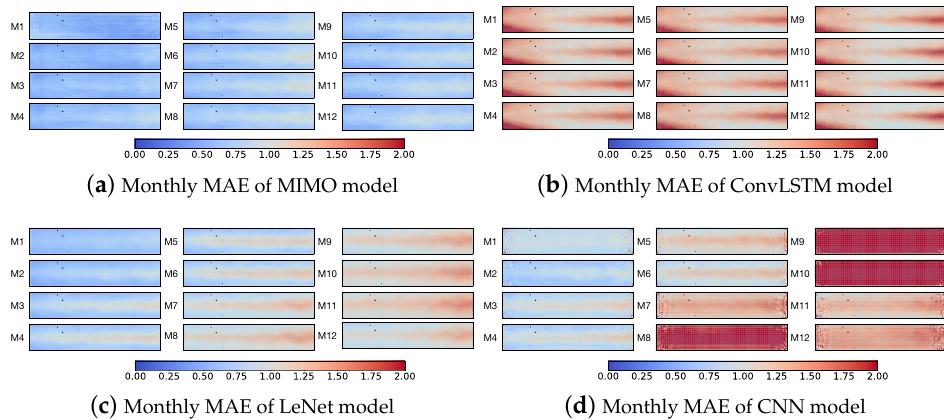
Figure 11. The results of monthly SST prediction in Ni ˜ no 3.4